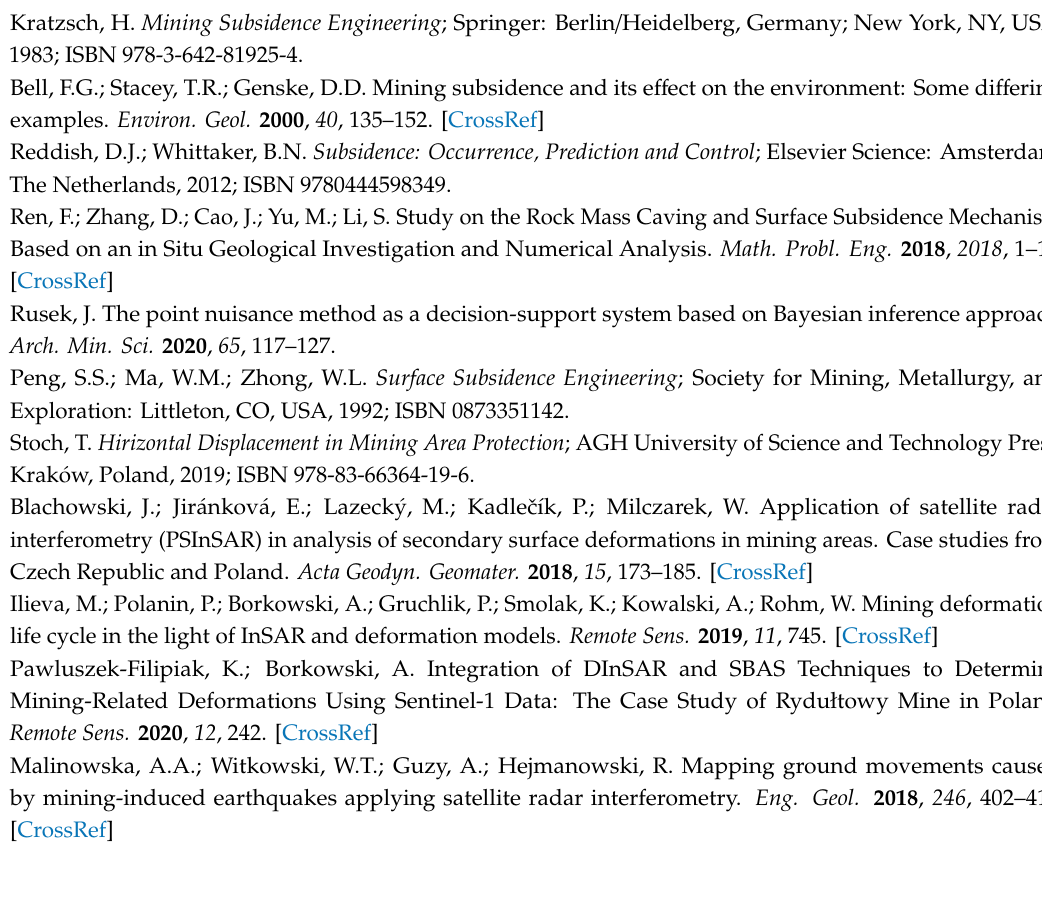
Figure A4. Discrepancies between vertical displacements determined via the UAV photogrammetric method (ORTO method) and reference measurements at the Jaworzno site.